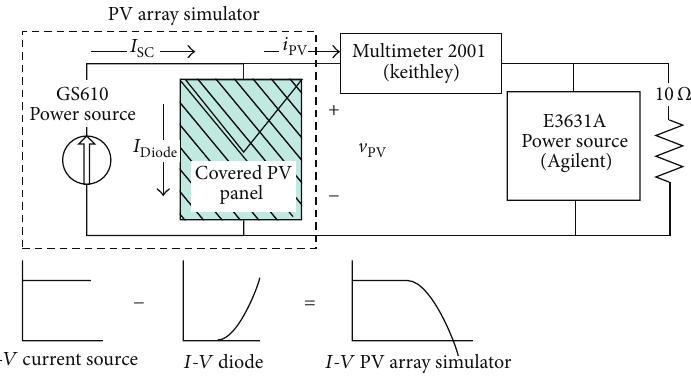
Figure 9: The PV array simulator and the setup used for its characterization.